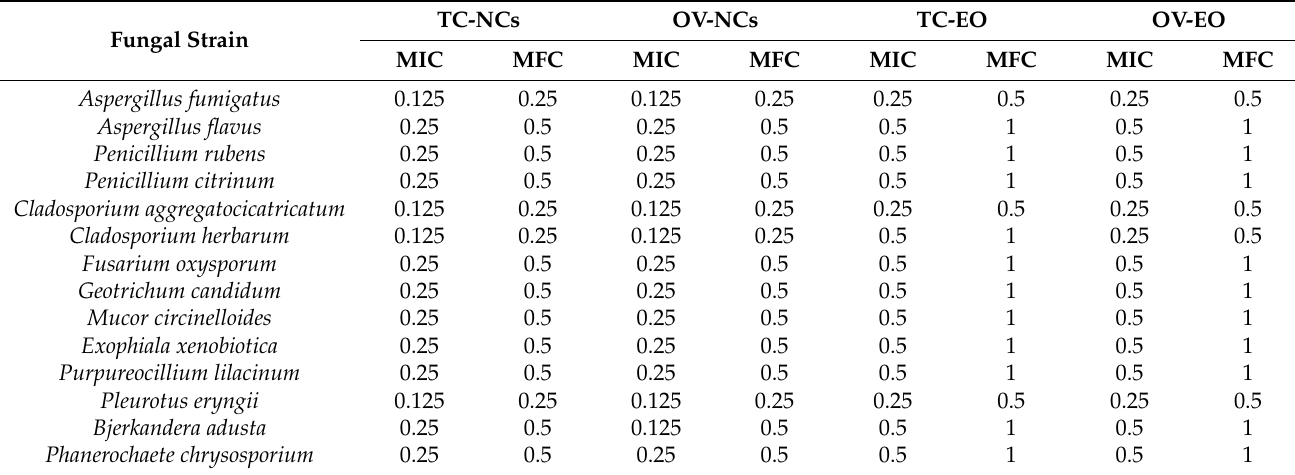
Table 4. Minimum inhibitory concentration (MIC) and minimum fungicidal concentration (MFC) values of encapsulated essential oils and pure essential oils.